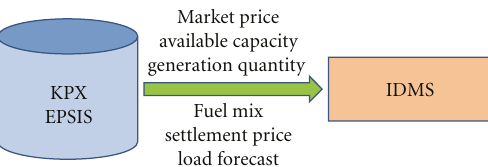
Figure 17: Periodic market data acquisition from